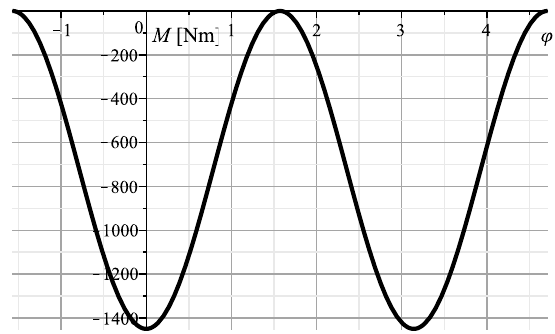
Figure 37: Plot of M ( φ ) (Example 5.4).